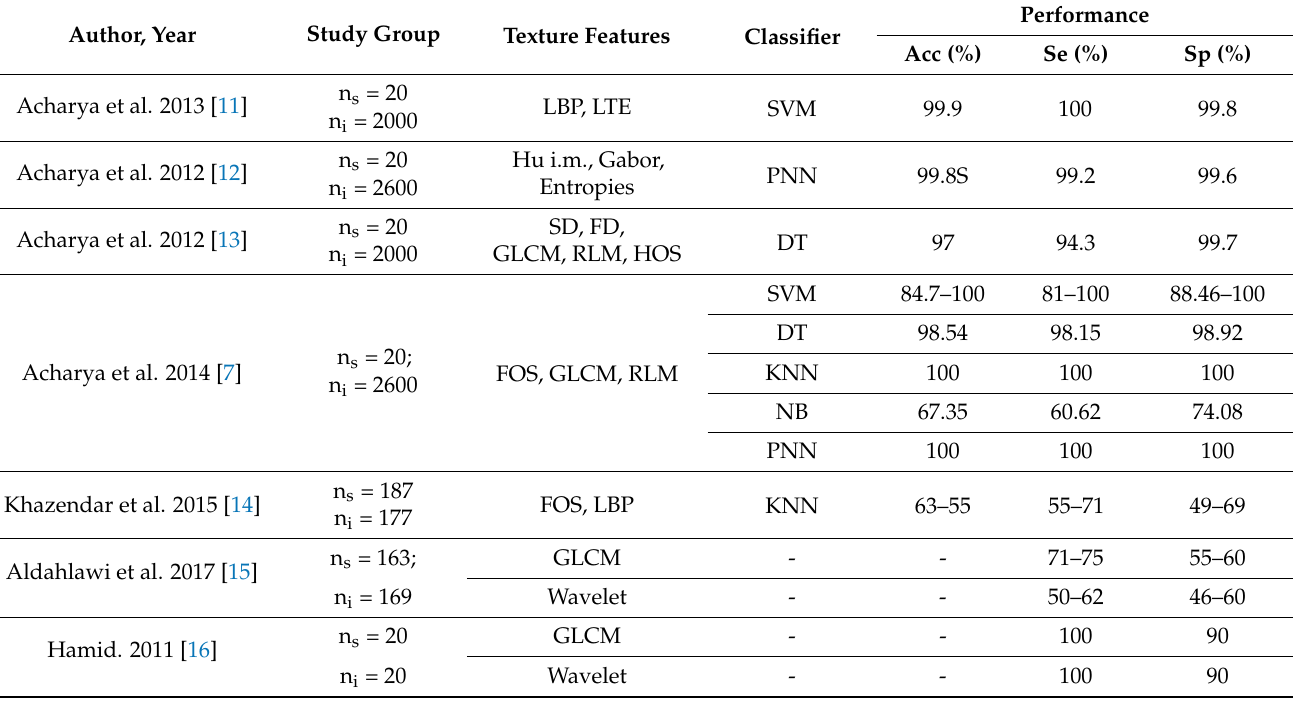
Table 5. Summary of benign and malignant ovarian masses classification using texture features from ultrasound